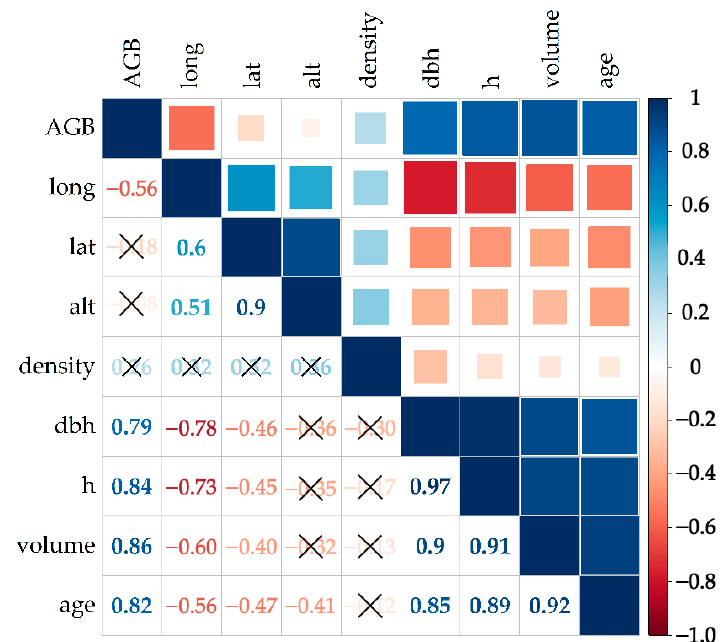
Figure 3. Pearson’s correlation coefficients between AGB and other variables represented by numbers and squares. Negative (red) numbers indicate that the corresponding variables are negatively correlated, whereas positive (blue) numbers represent positive correlations. Larger absolute numbers are indicated by darker colors, larger squares indicate stronger correlations, and the symbol “×” indicates insignificant correlations.